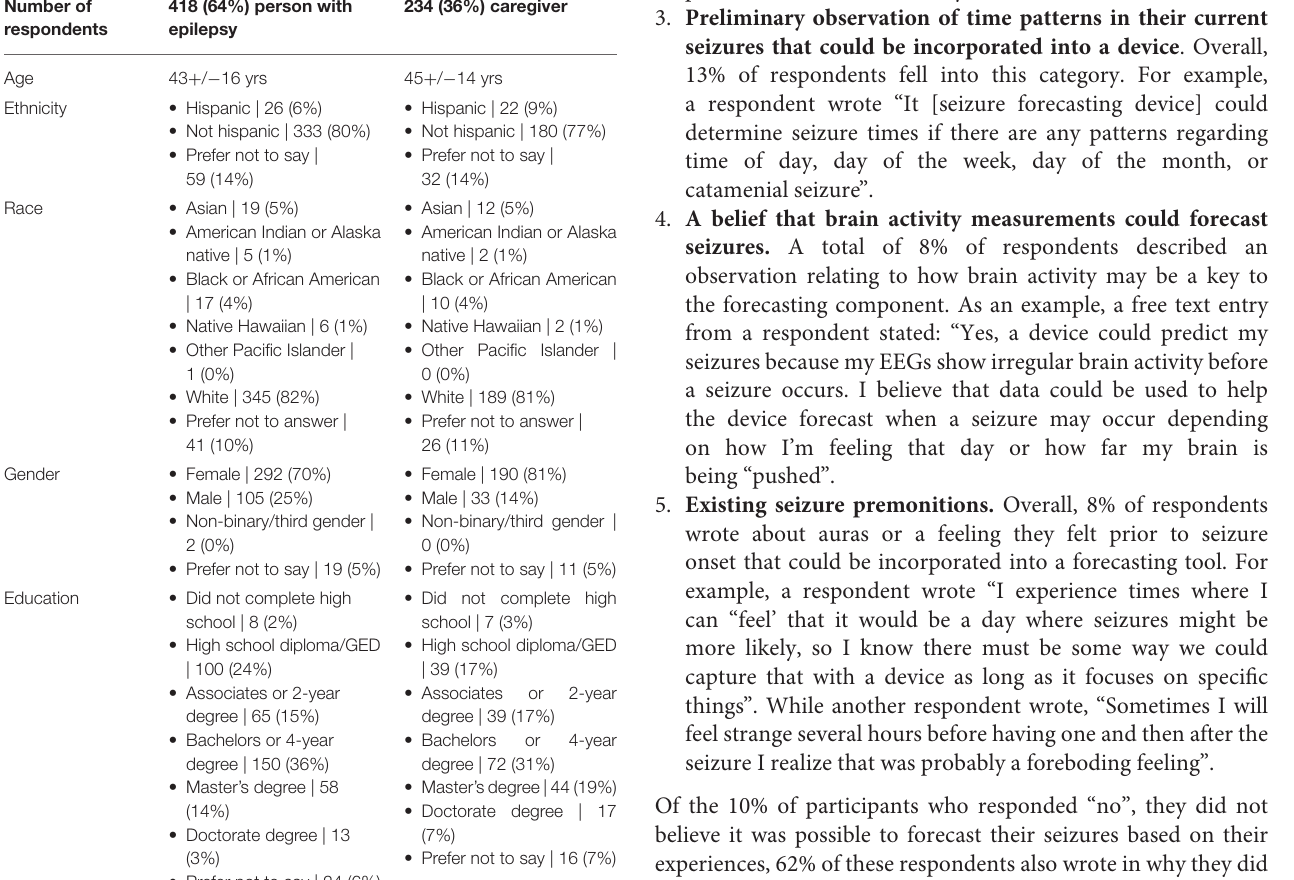
TABLE 1 | Demographics on seizure forecasting survey responses. Number of